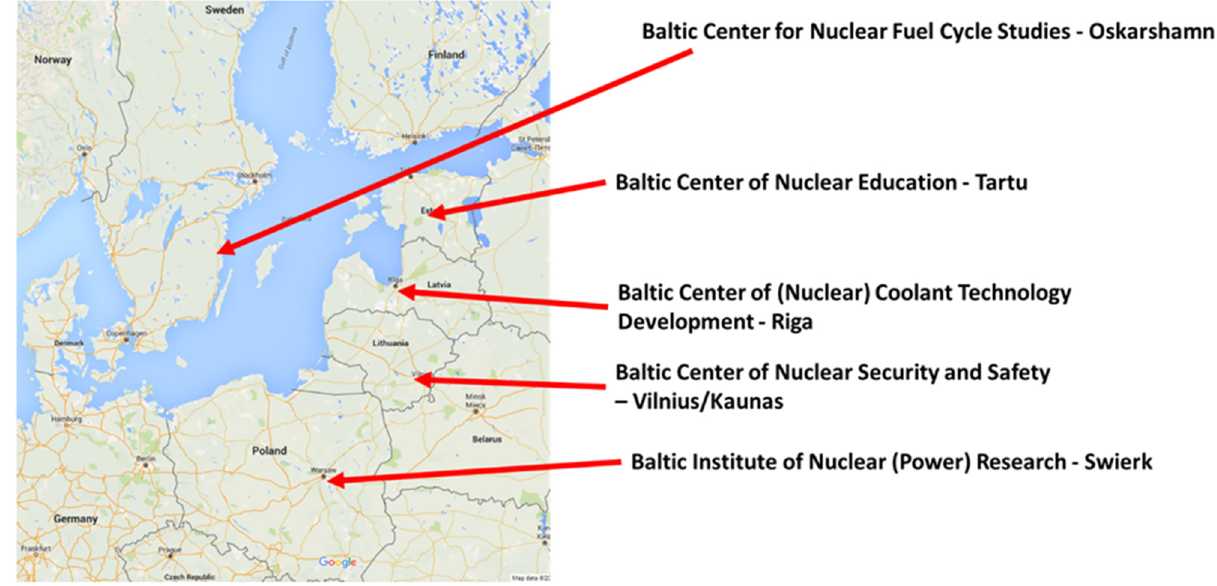
Fig. 4. Centers in the BRILLIANT